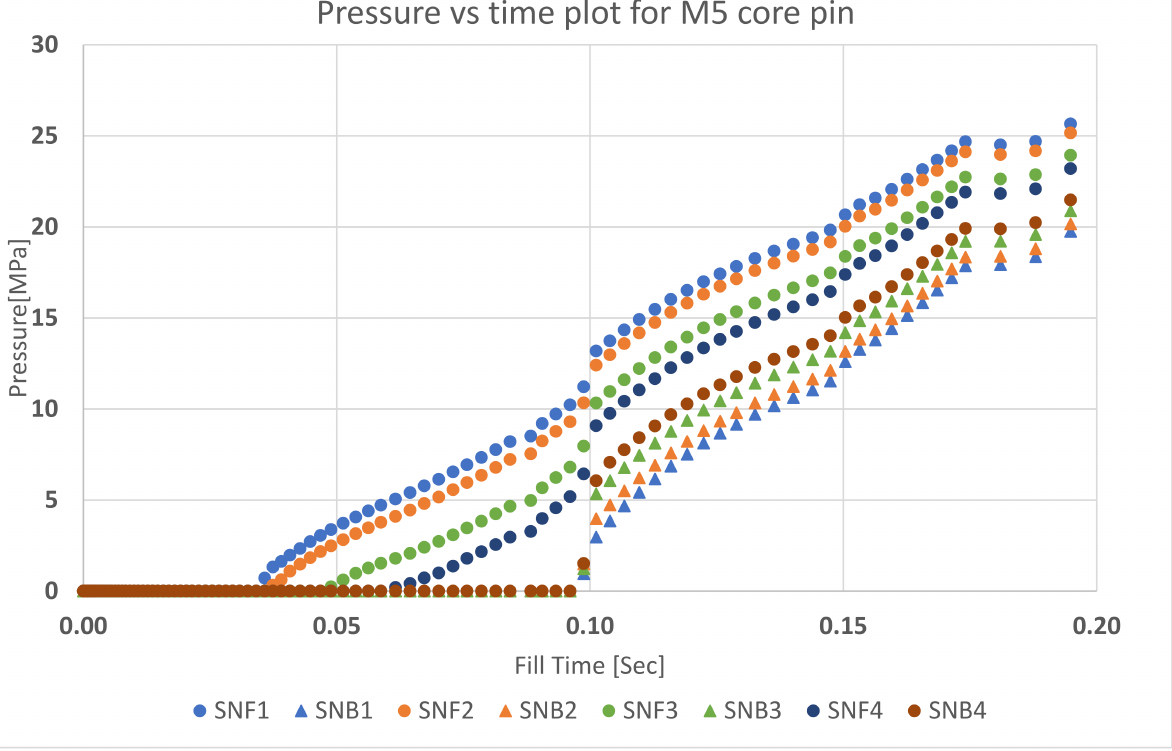
Figure 9. Pressure vs. time plot for M5 core pin. Sensor nodes are colour coded to depict the pressure difference between the front and back face of the core pin at different heights on the core pin.